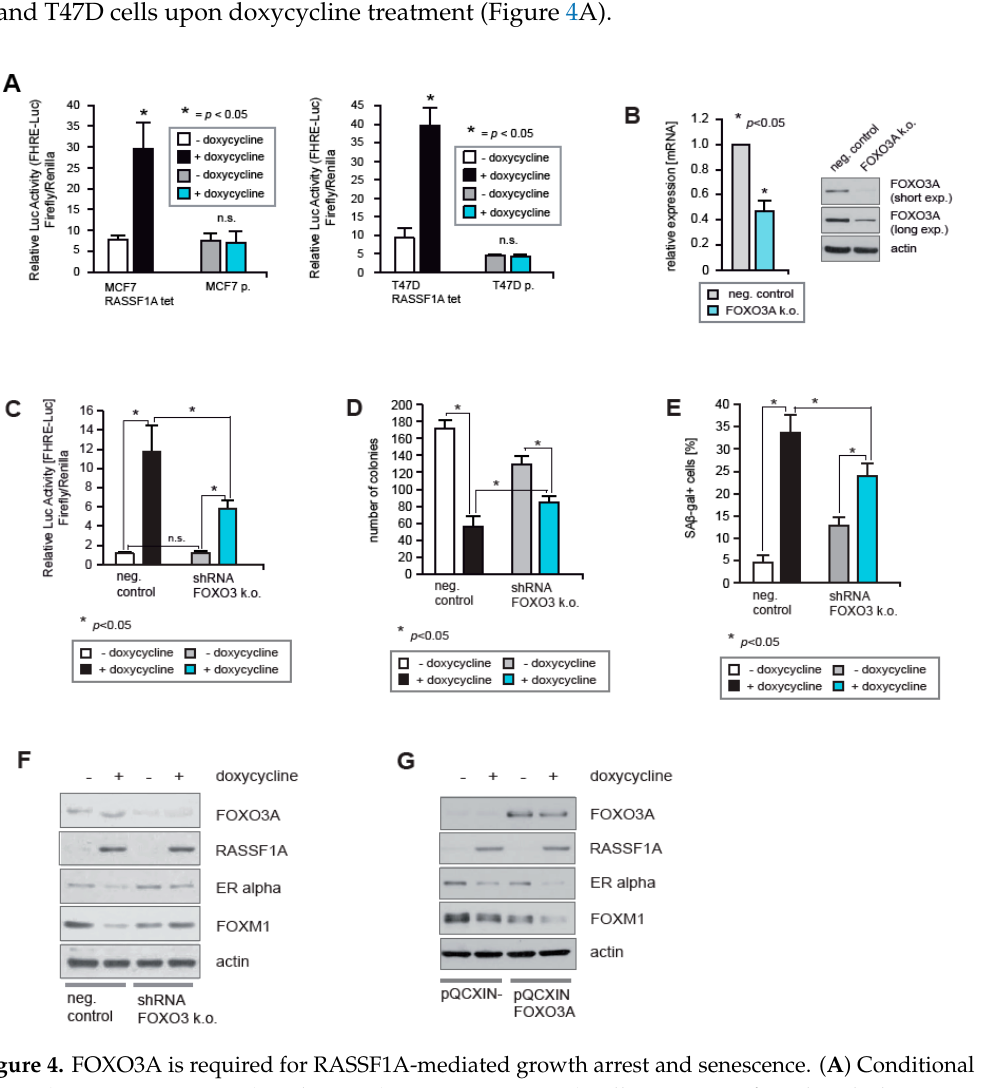
Figure 4. FOXO3A is required for RASSF1A-mediated growth arrest and senescence. ( A )